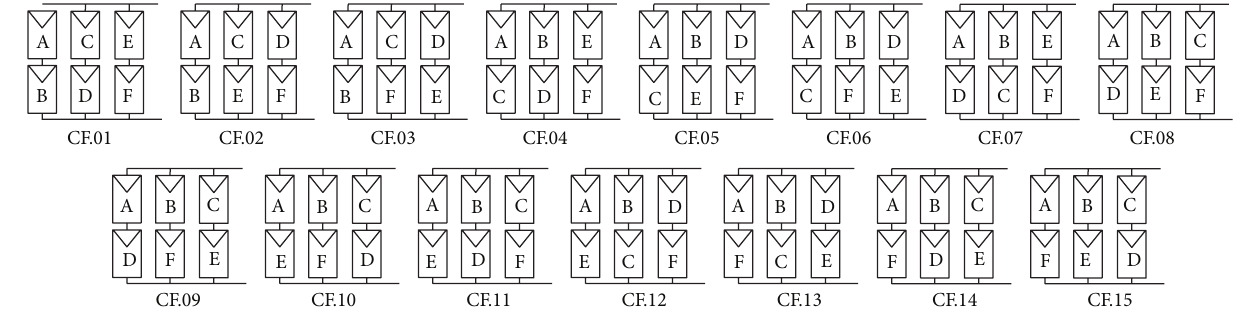
Figure 5: Settings of interest for a 2 × 3 matrix. Table 3: Part of the Information System of a 2 × 3